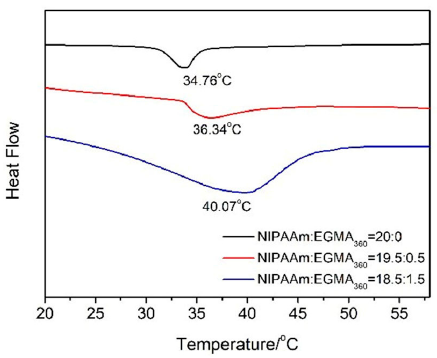
Figure 5. Differential scanning calorimetry (DSC) thermograms of alginate-Ca 2+ /P(NIPAAm- co -EGMA 360 ) hydrogels. The monomer ratios of NIPAAm to EGMA360 are 20:0, 19.5:0.5 and 18.5:1.5.